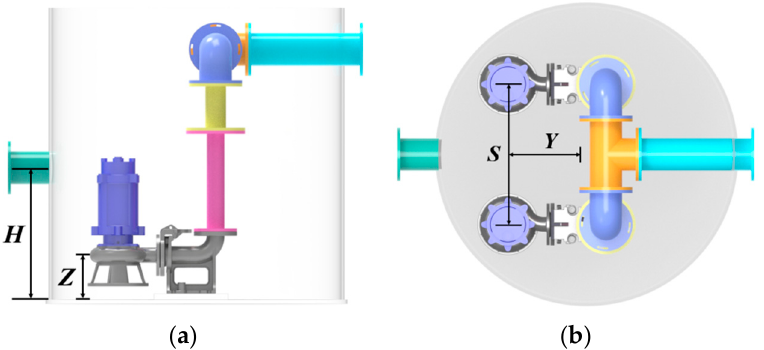
Figure 6. Schematic diagram of optimized parameters of prefabricated pumping station. ( a ) Side view. ( b ) Top view.